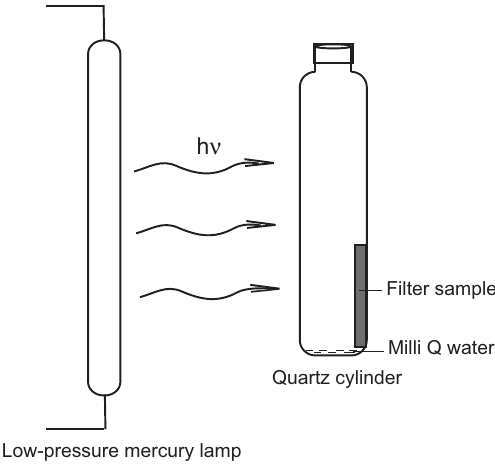
Figure 2. Schematic of experimental setup for irradiation of atmo- spheric aerosol filter